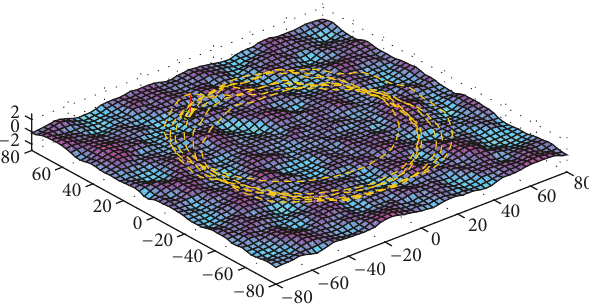
Figure 8: USV trajectory for a simulation under Sea State